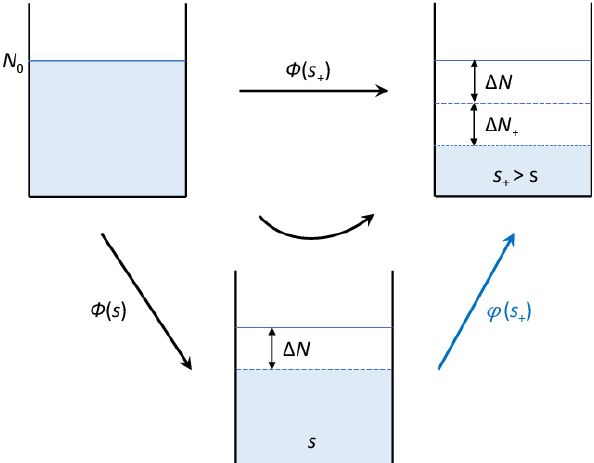
Figure 1. In a pool of N 0 ice-nucleating particles, (cid:49)N ice crys- tals form at ice supersaturation s , and (cid:49)N + additional ice crystals form at a higher value, s + . The resulting ice crystal numbers can be directly predicted from time-independent, cumulative ice-active fractions, φ , based on the original INP sample of size N 0 (“no bud- get” approach, black arrows labeled with φ ). When already acti- vated INPs are removed at s (“budget” approach, curved arrow), φ can no longer be used at s + because of the reduced sample size, ( N 0 − (cid:49)N ). This study derives differential ice-active fractions, ϕ , that can be applied to derive (cid:49)N + from the smaller sample (blue